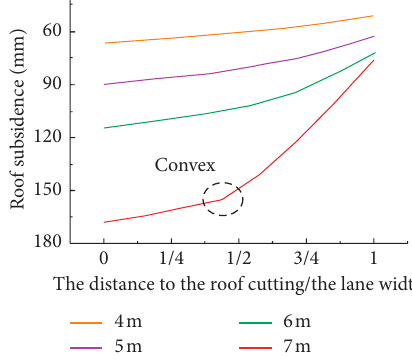
Figure 15: Vertical displacement of